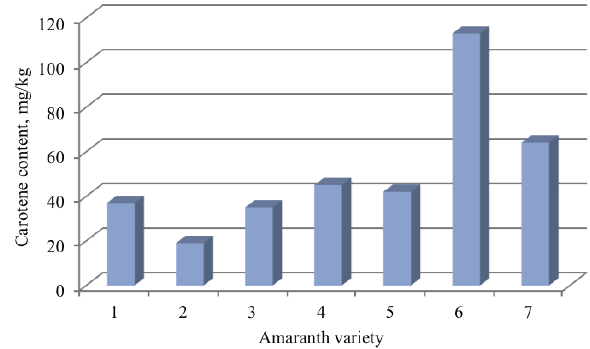
Figure 3 Carotene content in amaranth leaves by variety: 1 – Voronezh-36, 2 – Imperator, 3 – Rubin, 4 – Universal, 5 – Gigant, 6 – Dobrynya, 7 –